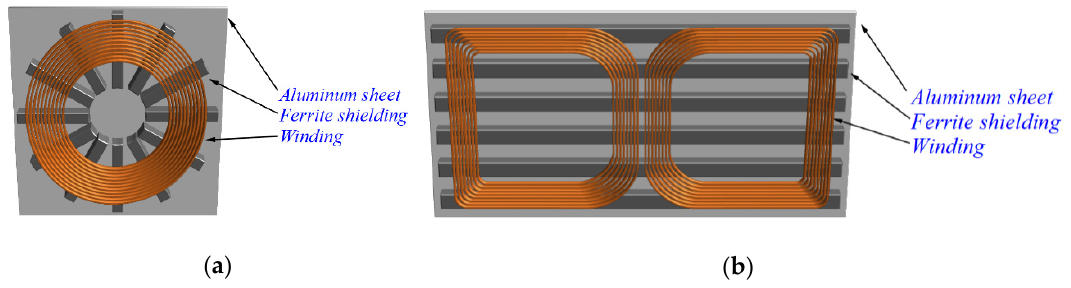
Figure 6. Flat circular coil coupler ( a ); Double D coupler configuration ( b ).